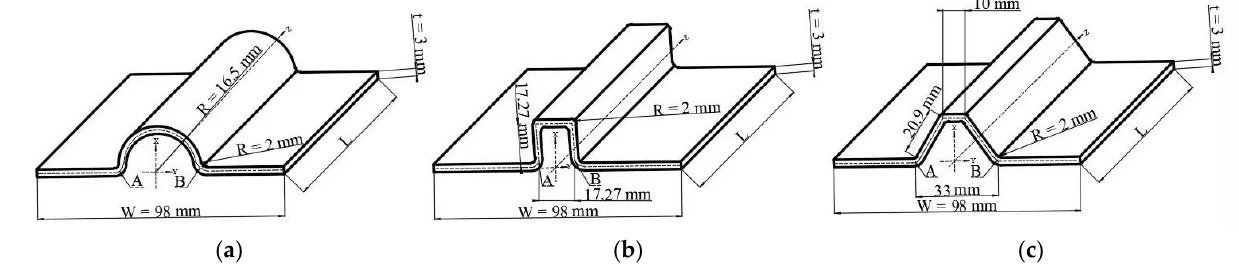
Figure 1. Geometries of the different cross-sectioned stiffeners: ( a ) Type I (semicircular), ( b ) Type II (rectangular), and ( c ) Type III (trapeziform).